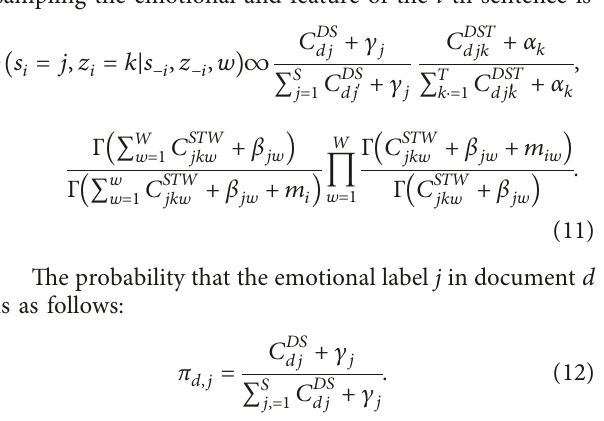
Figure 4: Attribute-level emotional analysis method of short text based on the lifetime topic model.